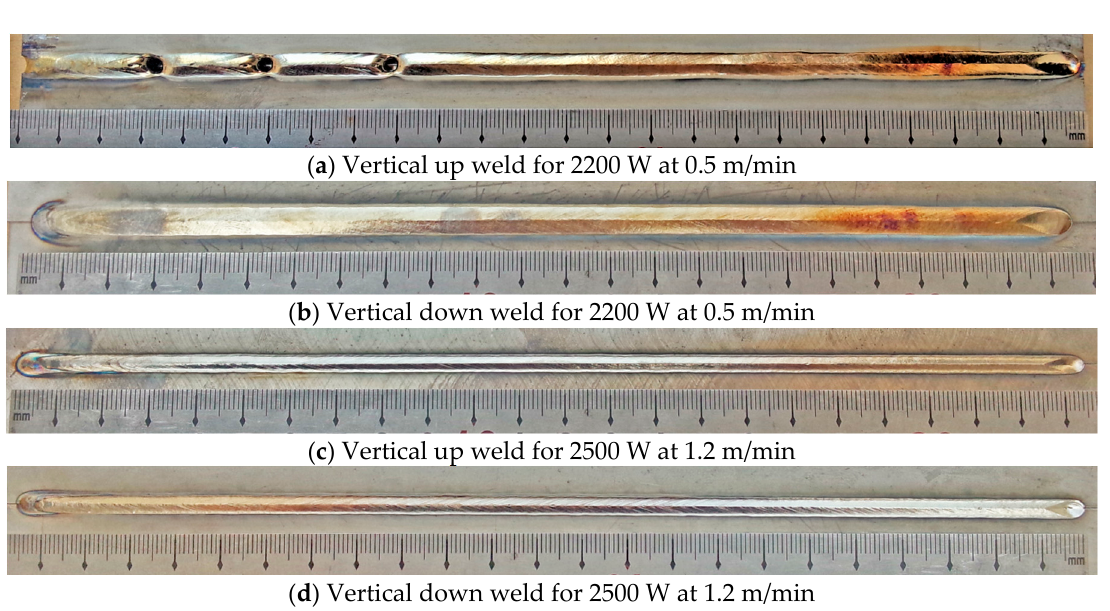
Figure 3. Appearances of butt weld beads made using different welding positions and process parameters.